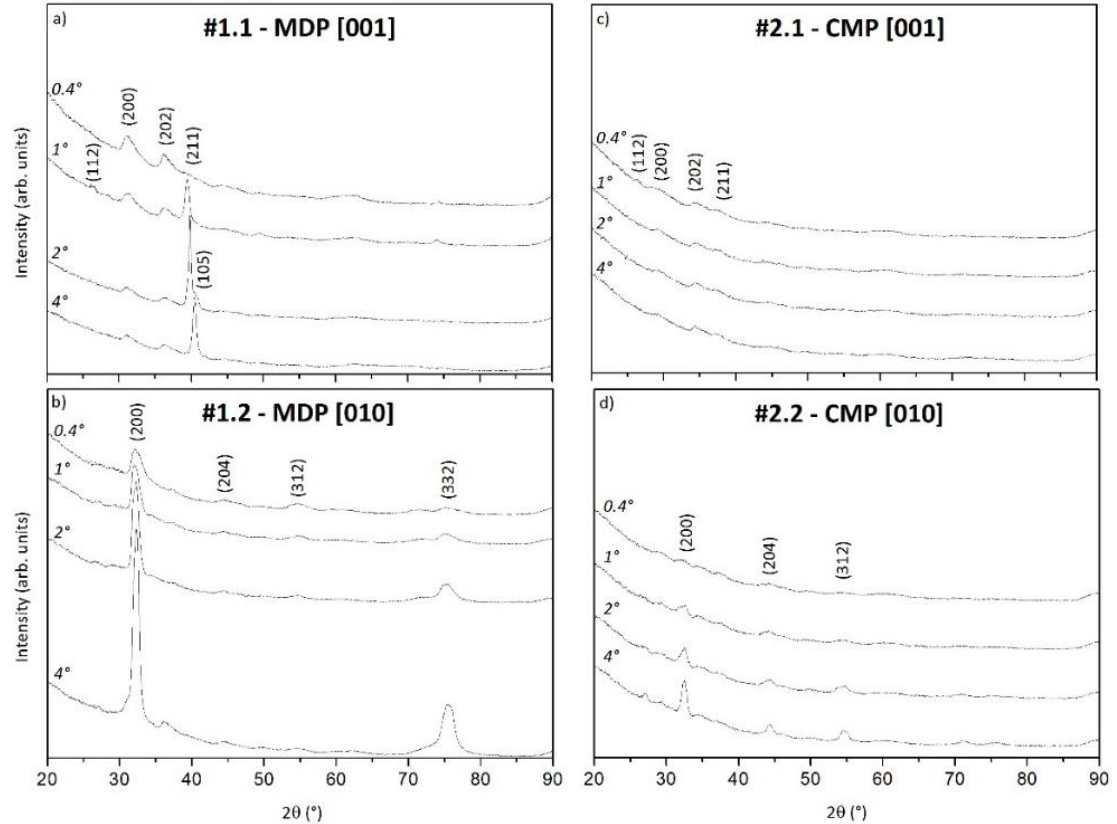
Figure 4. The Grazing Incidence X-ray Diffraction (GID) patterns of the Mechanical Diamond Polishing (MDP) and Chemical Mechanical Polishing (CMP) samples taken at four incidence angles (0.4°, 1°, 2°, and 4°) on the two different crystal orientations: ( a ) MDP [001], ( b ) MDP [010], ( c ) CMP [001], ( d ) CMP [010].